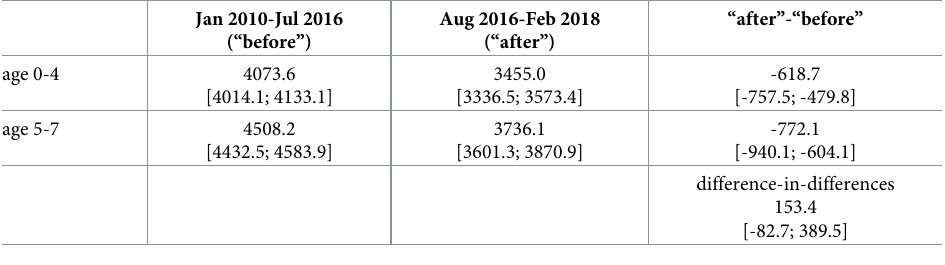
Table 3. Antibiotic use by age group and time periods. Average values of monthly cohort specific antibiotic DOT per calendar